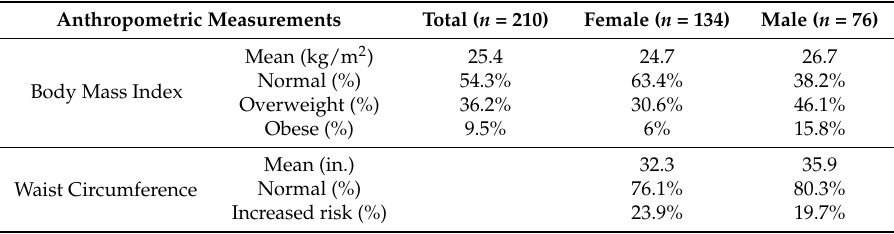
Table 2. BMI and waist